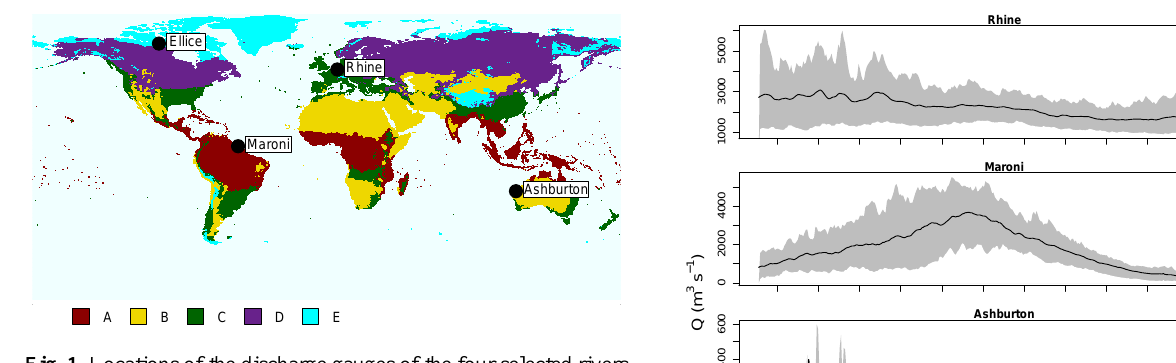
Fig. 1. Locations of the discharge gauges of the four selected rivers within the five major climate types.